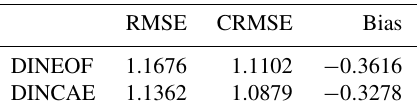
Table 3. Comparison with the World Ocean Database for SST grid points covered by clouds. The RMSE, CRMSE and bias are in de- grees